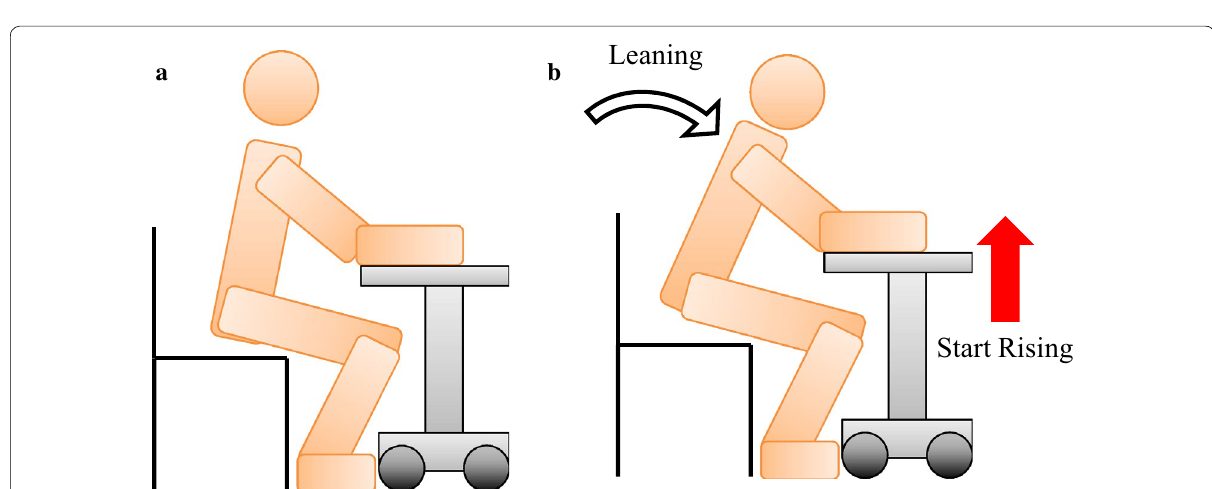
Fig. 5 Guidance and support procedure (pattern 2.) a User is sitting; b armrest start uprising at beginning of